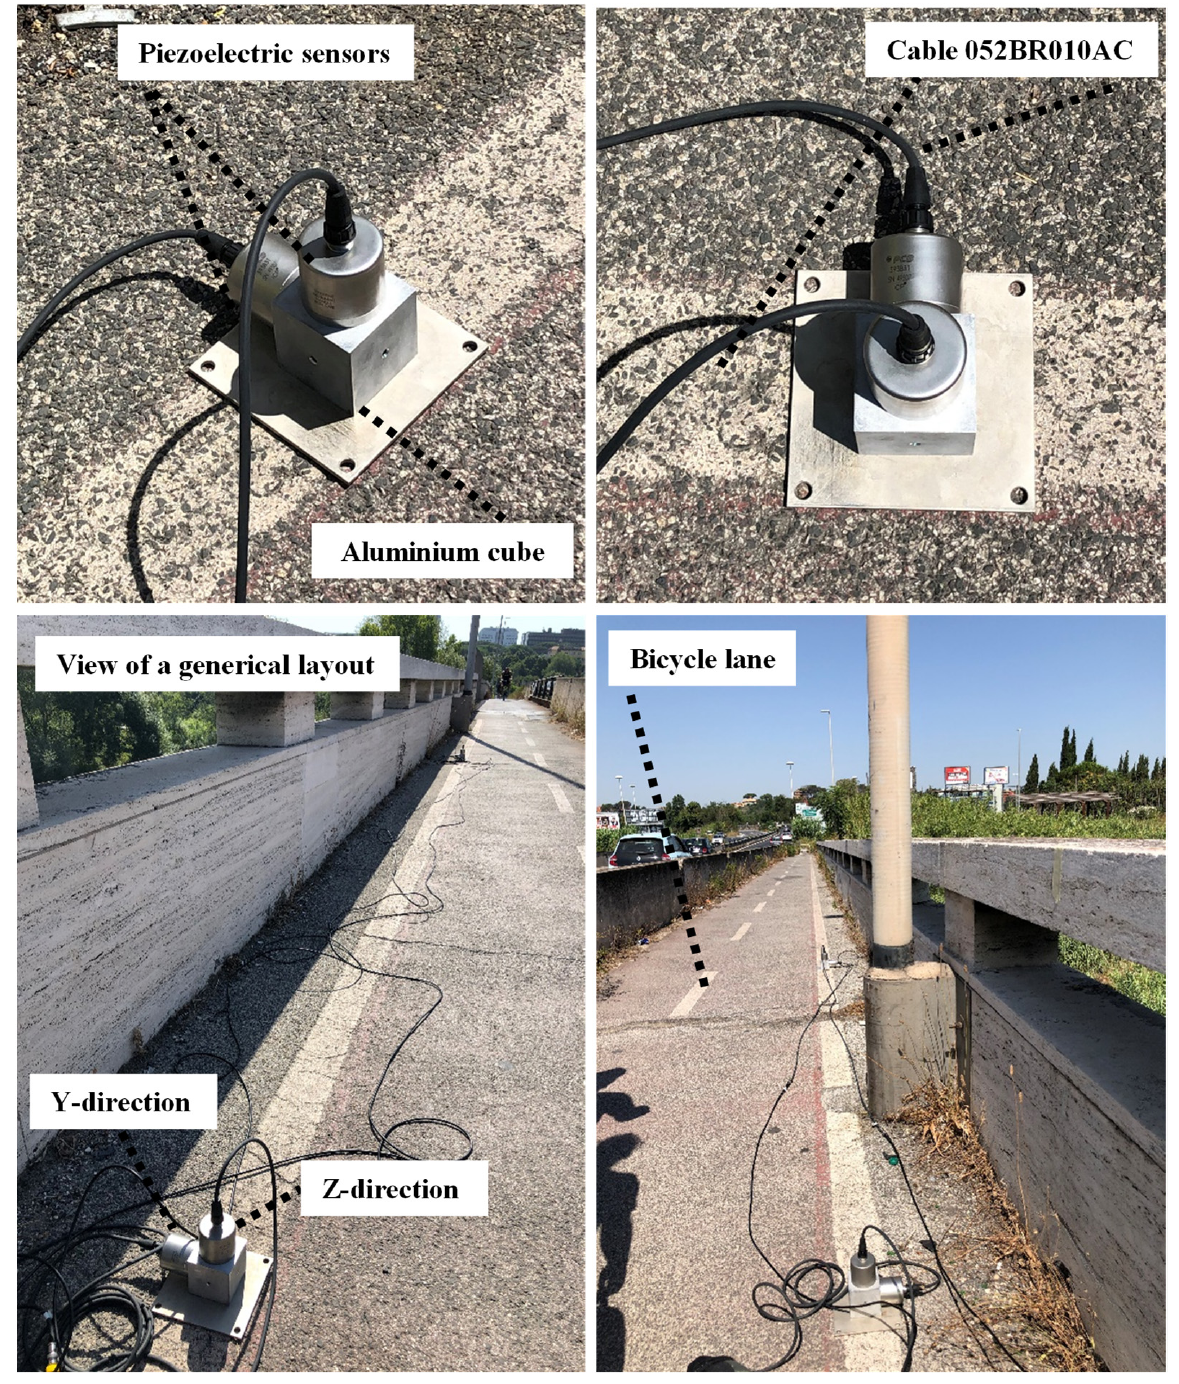
Figure 6. Accelerometers and examples of the experimental layout installation on the bridge.